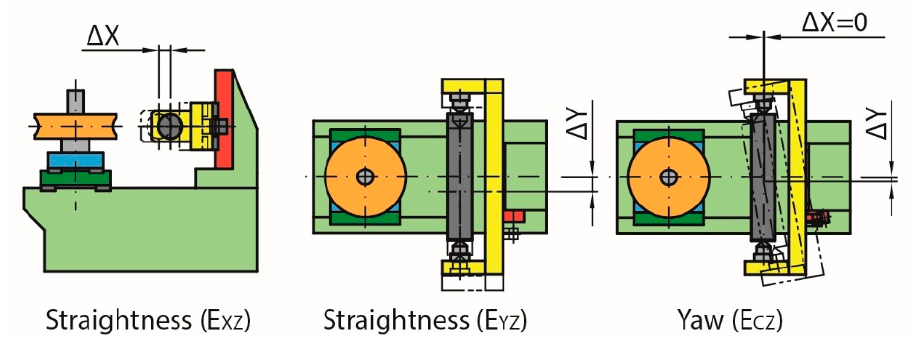
Figure 12. Pitch error (E BZ ).